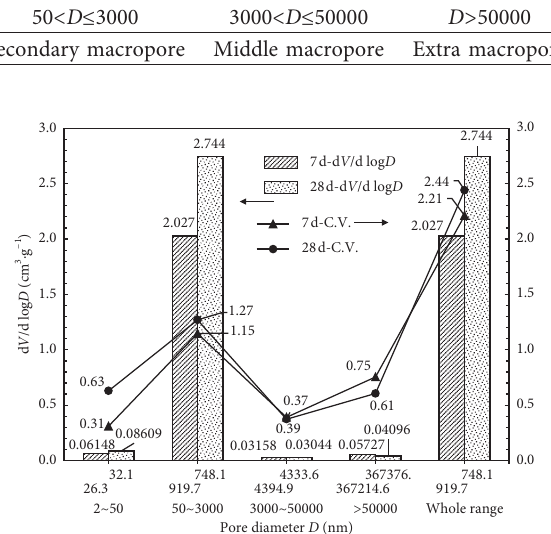
Figure 14: The d V /d log D of MPD and its C. V. in pore-diameter ranges of different W/C ratio NCG concretion.